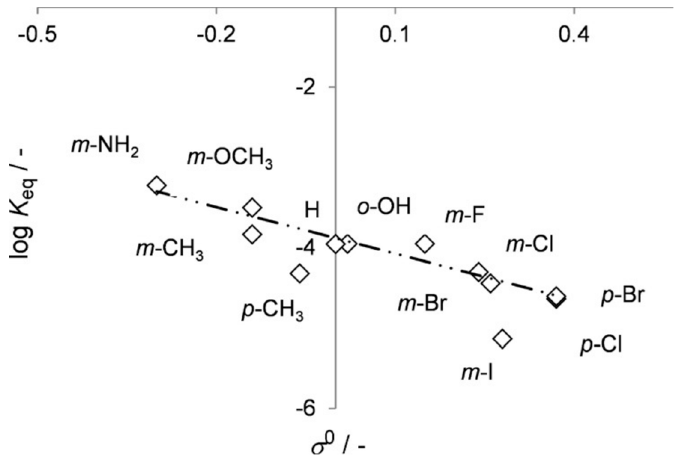
Figure 19. Correlation of the logarithm of the calculated K eq,app with respect to the Taft constants ( σ 0 ) for substrates shown in Figure 18, (R 2 = 0.93). Reprinted with permission from [76]. Copyright 2016, John Wiley and Sons.